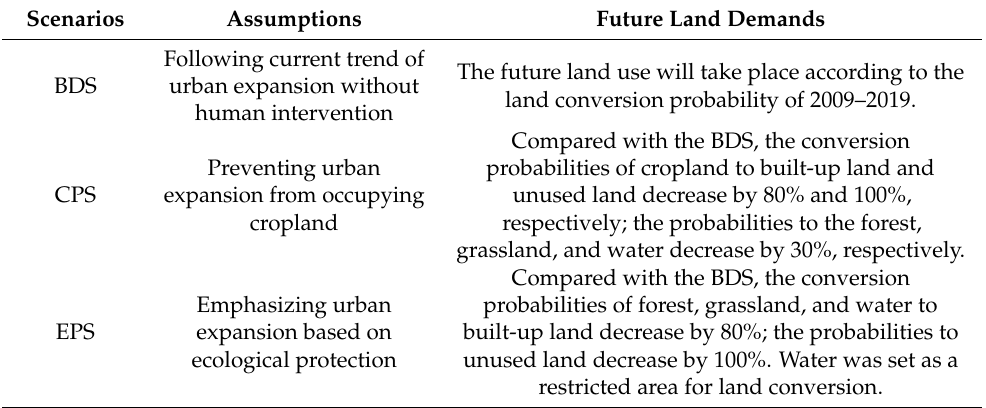
Table 1. Descriptions of three